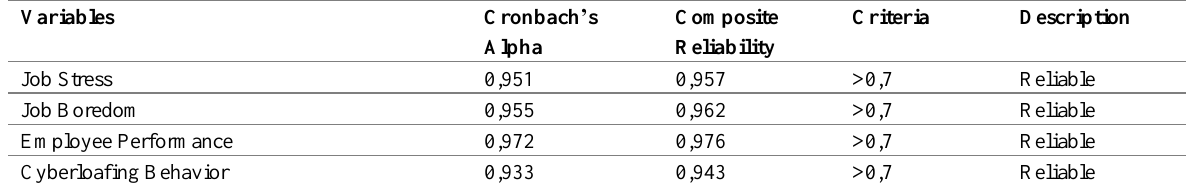
Table 6: Reliability Test Results-Composite